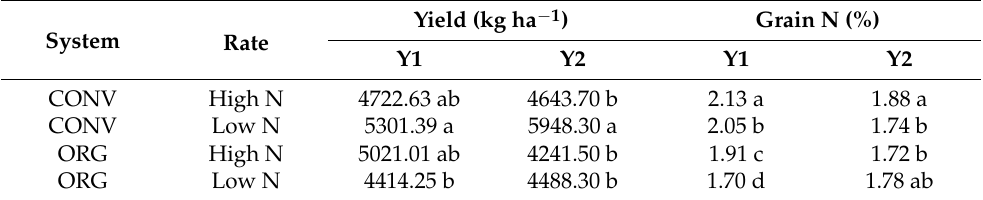
Table 3. The effect of production system and fertilizer N rate on grain yield and N content in both study years. (Same letters within each column are not significantly different based on Tukey’s honest significant difference (HSD) test performed at α = 0.05).